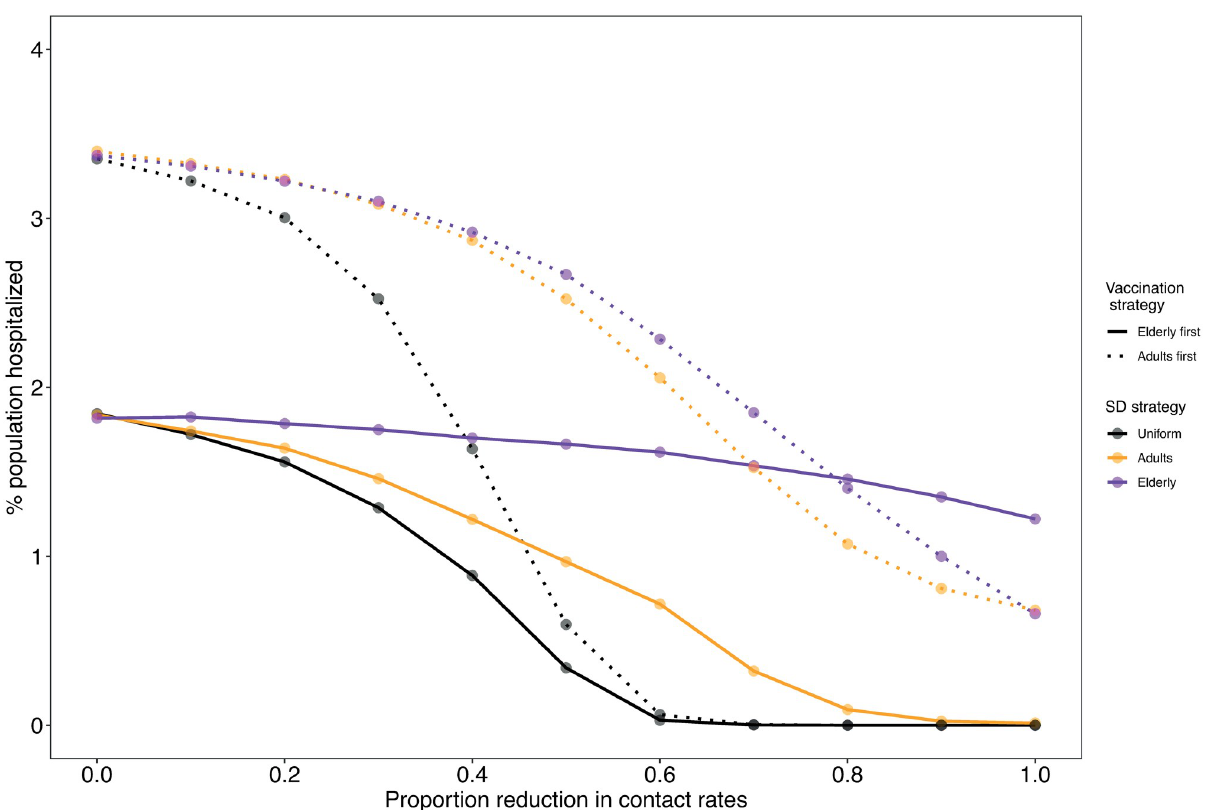
Fig 3. Effects of joint interventions on the proportion of the population hospitalized ( P H ). Each data point represents a combination of a vaccination strategy (solid vs. dotted lines) and a social distancing strategy (colors) at particular social distancing strength (x-axis). Simulations were run using a daily deployment of κ = 0.5% of the population.